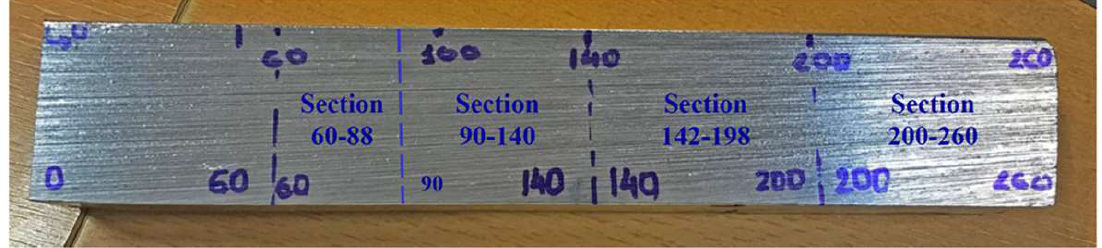
Figure 19. B-scan of the sample No.5 along the edge obtained by the TFM. The B scan corresponds to the section line, where the pipe was sliced before the metallographic examination. Vertical colour bar represents the peak-to-peak amplitude in arbitrary units.